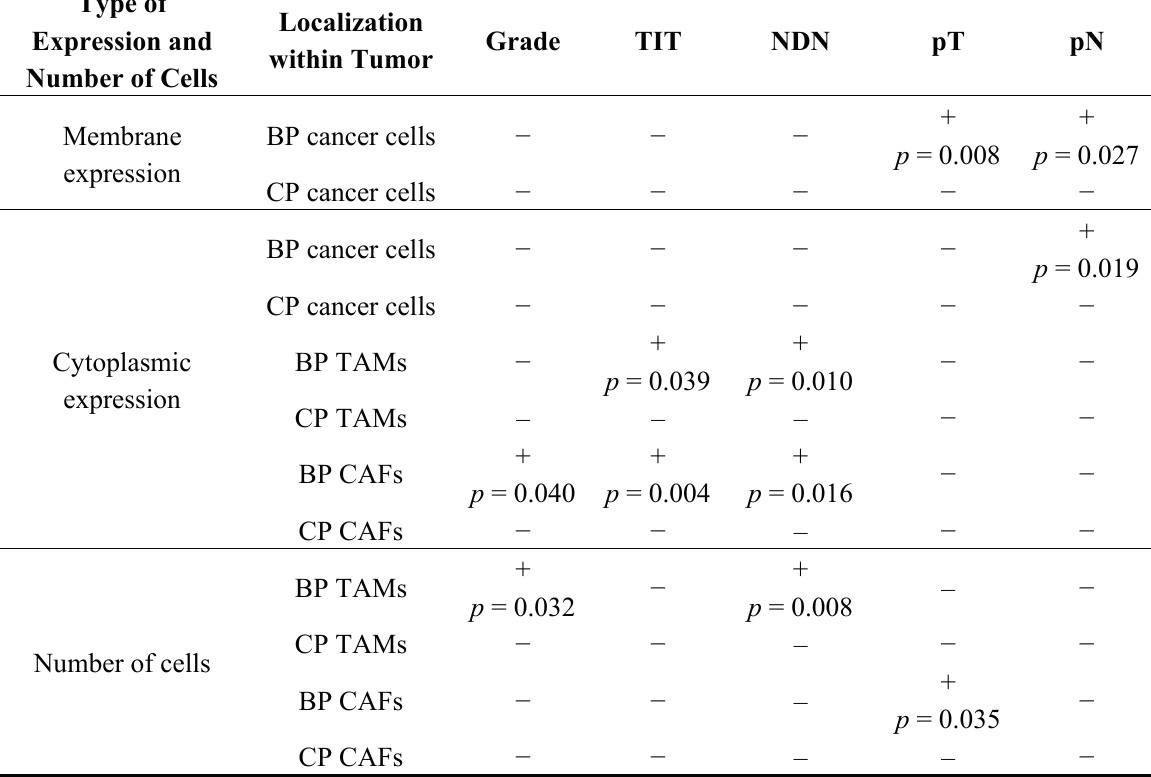
Table 1 summarizes relationship between RCAS1 and pathological markers of tumor behavior. Detailed discussion is provided below. Table 1. The presence (+) or absence (–) of statistical associations between tissue RCAS1 expression and pathological characteristics of urothelial bladder cancer. BP: border part of tumor; CP: central part of tumor; TAMs: tumor-associated macrophages; CAFs: cancer-associated fibroblasts. TIT-tissue invasion type, NDN-nonclassic differentiation number, pT-pathological assessment of primary tumor extent, pN-pathological assessment of metastases to nearbyregional lymph